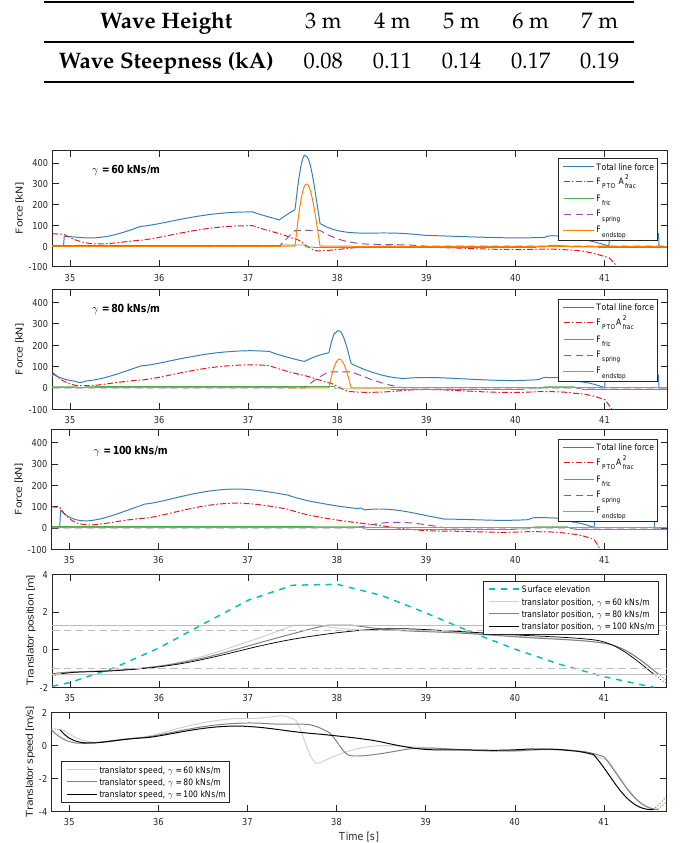
Figure 7. The total force in the connection line is a sum of of F PTO A 2 and the gravitational force. The line force is compared for three levels of generator damping γ . The corresponding translator position and speed are also seen. The surface elevation of the incident wave is seen together with the translator position. The horizontal dashed and solid lines mark the free and the total stroke length,